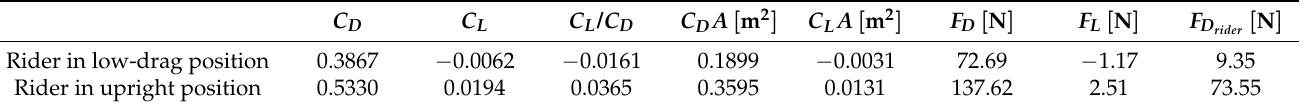
Table 3. Drag/lift forces and coefficients for different positions taken by the